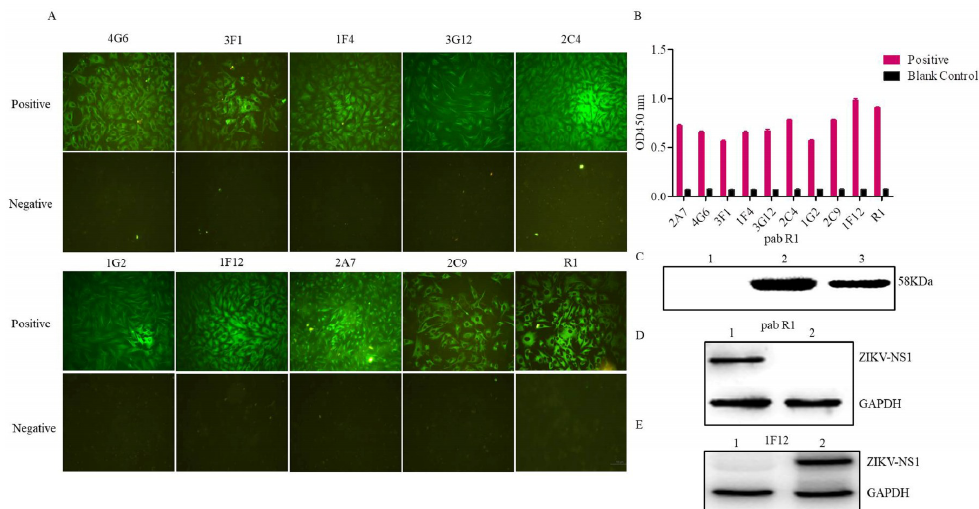
Figure 2. Evaluation of the pAb R1 and mAbs against ZIKV-NS1 protein. ( A ) Indirect immunofluorescent assay of the mAbs and pAb R1, Scale bar = 100 µ m. ( B ) ELISA test of the mAbs and pAb R1. ( C ) Western blot analysis of the pAb R1; lane 1: E. coli Rosetta (DE3) without IPTG; lane 2: E. coli Rosetta (DE3) induced with IPTG; lane 3: the purified ZIKV-NS1. ( D ) ZIKV infected (lane 1) and mock-infected Vero cells (lane 2) were used for Western blot analysis using pAb R1. ( E ) Mock-infected (lane 1) and ZIKV infected Vero cells (lane 2) were used for Western blot analysis using mAb